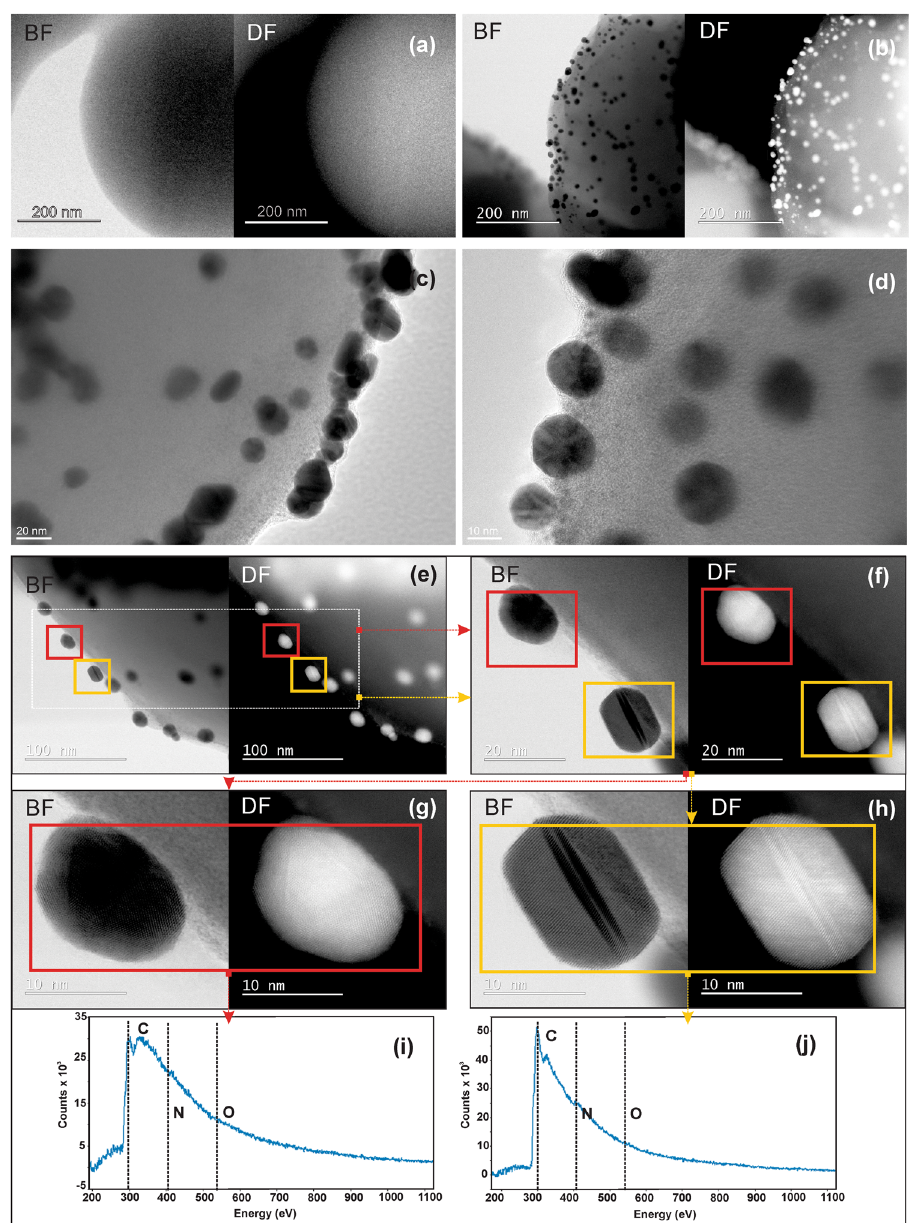
Figure 3. Functionalization of the surface of Au nano-features by nisin. Bright and dark filed (BF and DF) STEM images of C -template with nisin (without Au nanofeatures) ( a ) and C -template with nisin-functionalized Au nanofeatures ( b ); amorphous layer at the surface of nisin- functionalized Au nano-features at C -templates ( c , d ); BF and DF images of selected Au/nisin nano-features at the surface of C - templates ( e , f ) as well as selected spherical Au/nisin nano-features at the surface of C - templates (marked in red) ( g ) and selected twinned hexagonal Au/nisin nano-features at the surface of C - templates (marked in orange) ( h ) with EELS spectra taken from the surface of selected spherical ( i ) and selected twinned hexagonal ( j ) Au